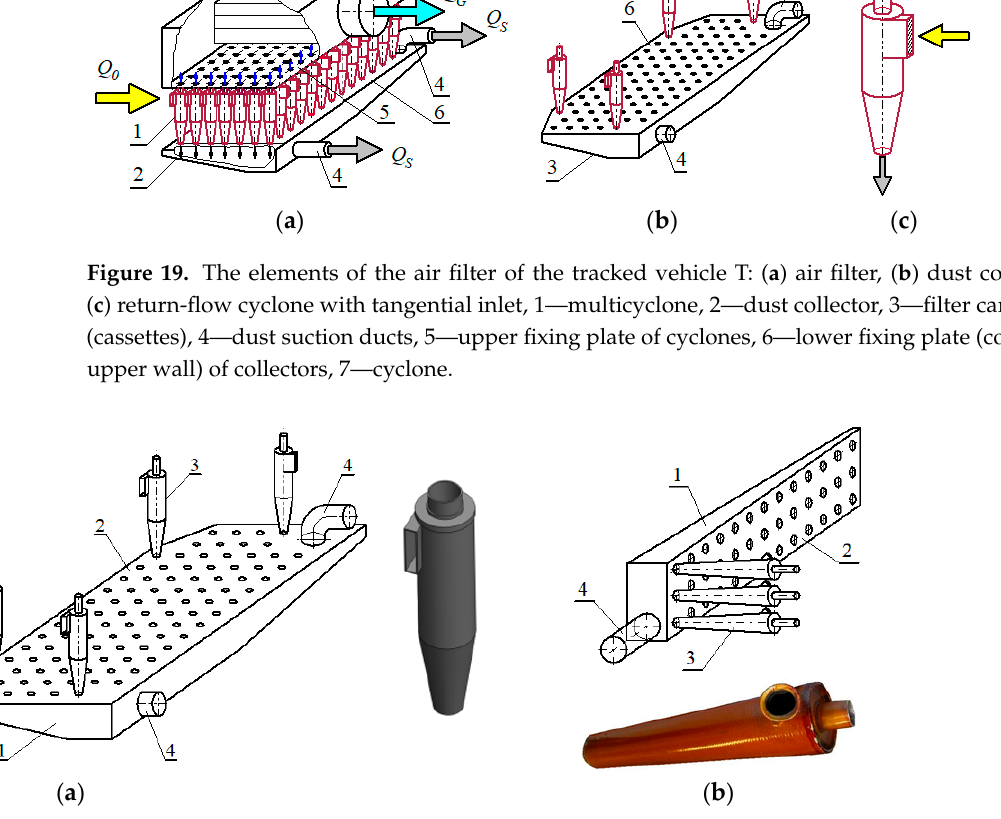
Figure 19. The elements of the air filter of the tracked vehicle T: ( a ) air filter, ( b ) dust collector, ( c ) return-flow cyclone with tangential inlet, 1—multicyclone, 2—dust collector, 3—filter cartridge (cas- settes), 4—dust suction ducts, 5—upper fixing plate of cyclones, 6—lower fixing plate (collector up- per wall) of collectors, 7—cyclone.